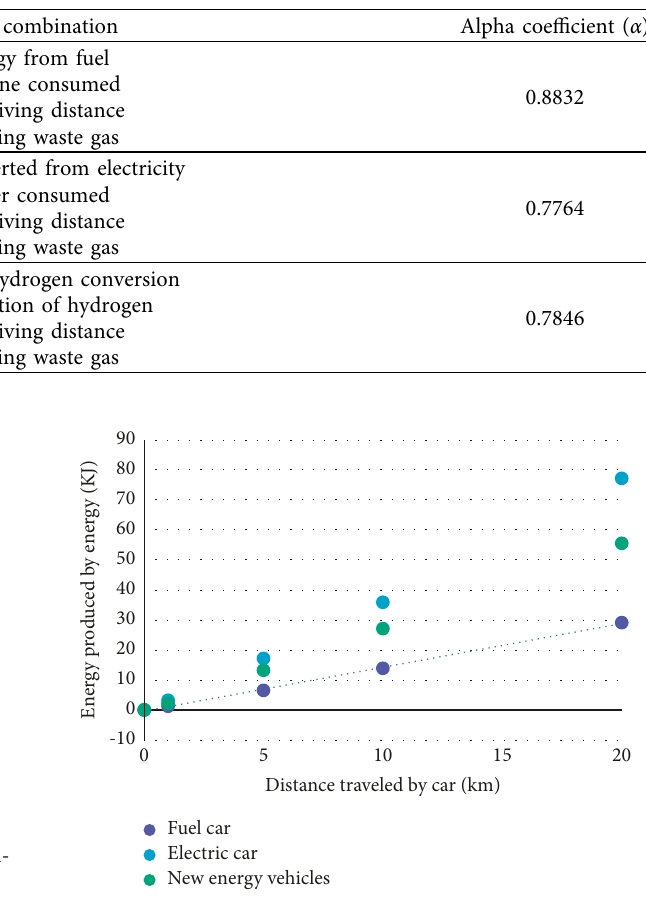
Figure 2: Analysis diagram of resource consumption of three kinds of cars driving the same